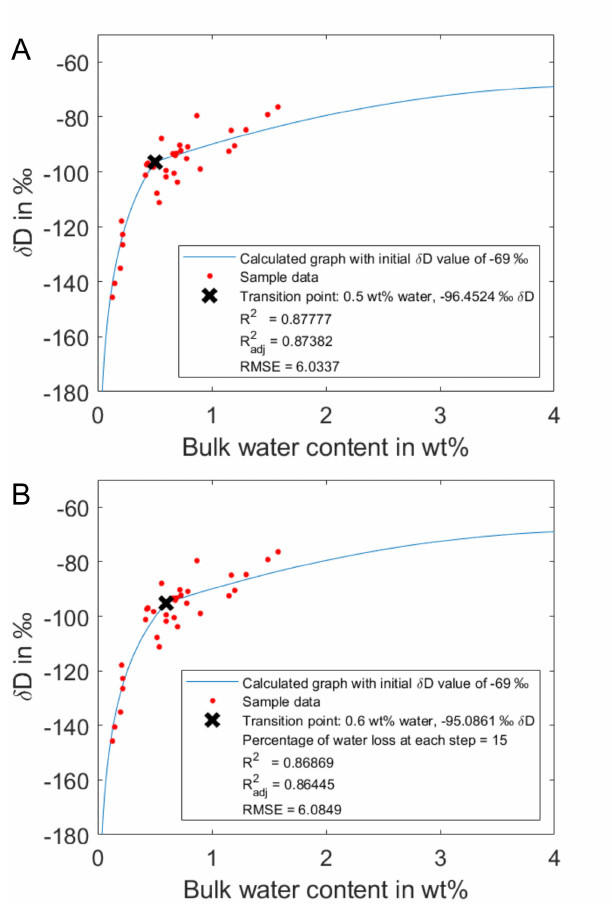
Figure 7: Two-stage, closed-to-batched system model fits to Chaitén pyroclastic obsidian and lava δ D–H data [Castro et al. 2014] showing transition points (black ˆ ’s) at [A] 0.5 and [B] 0.6 wt.% H di ff er from [A] a small fixed step size 0.001 wt.%, to [B] a variable one comprising 15 % H